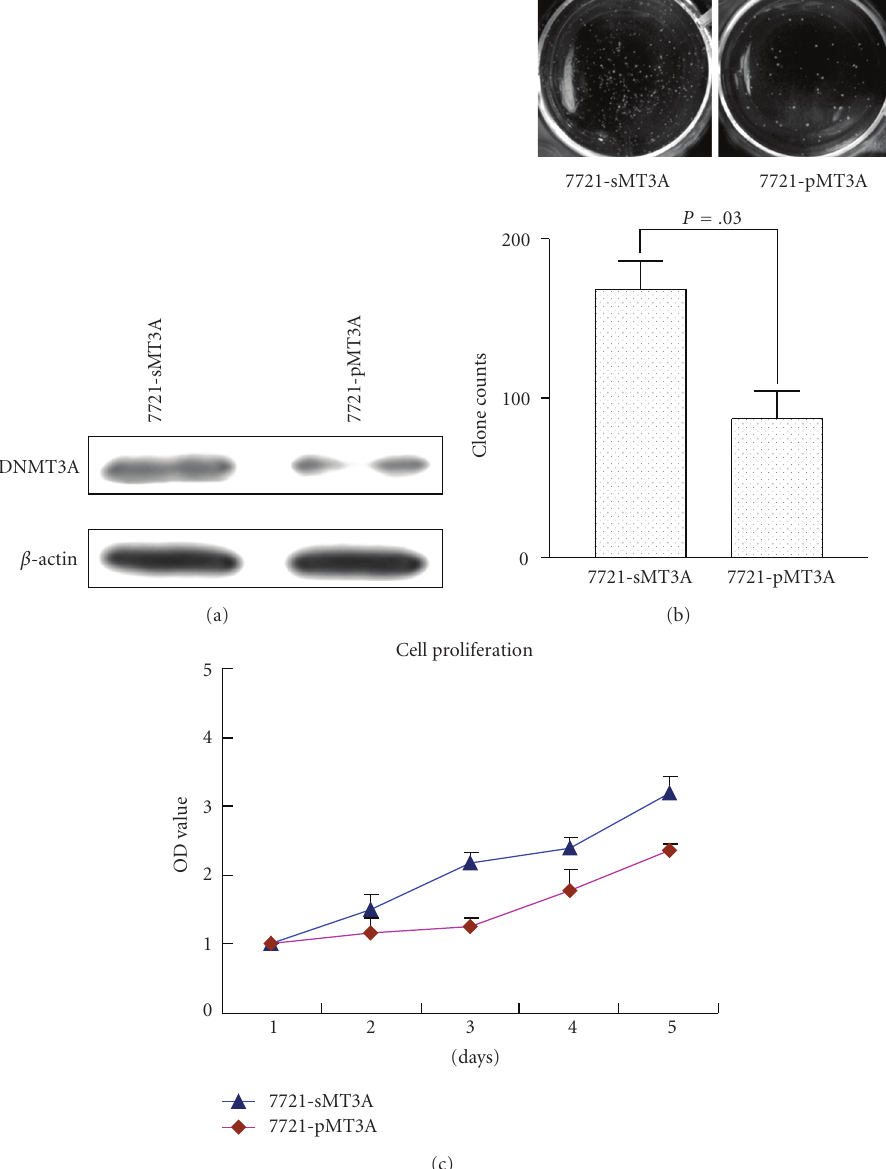
Figure 3: Depletion of DNMT3A suppressed HCC cell growth and colony formation ability. (a) Expression of DNMT3A was stably suppressed in SMMC-7721. 7721-sMT3A, which is transfected with scramble vector sMT3A, 7721-pMT3A, which is transfected